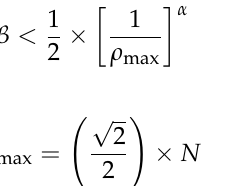
template center and the pixel point. Then the template is moved horizontally